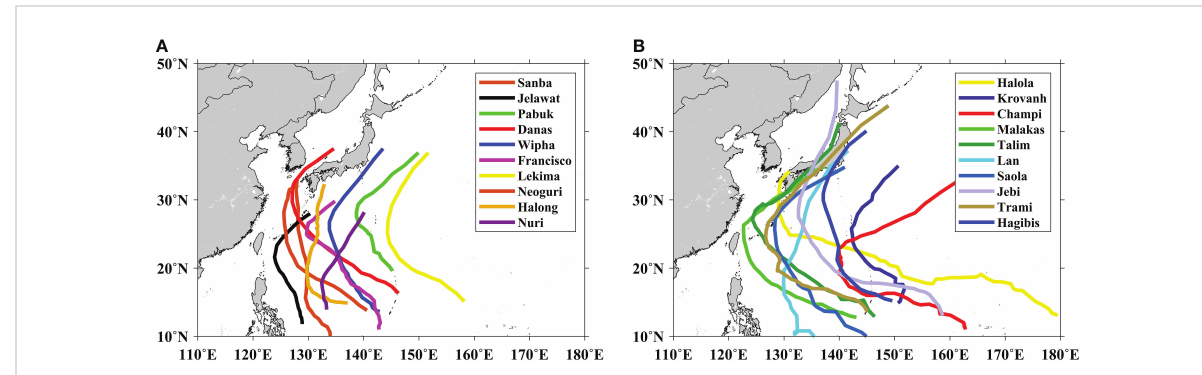
FIGURE 2 Spatial distribution of the representative typhoon passage tracks used in this study for (A) Aquarius (2011 – 2015) and (B) Soil Moisture Active Passive (SMAP) (2015 – 2020) in the Northwest Paci fi